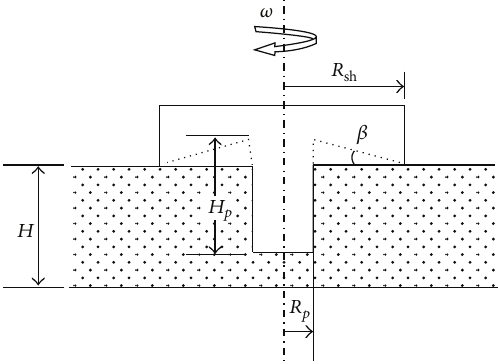
Figure 1: Schematic illustration of the tool